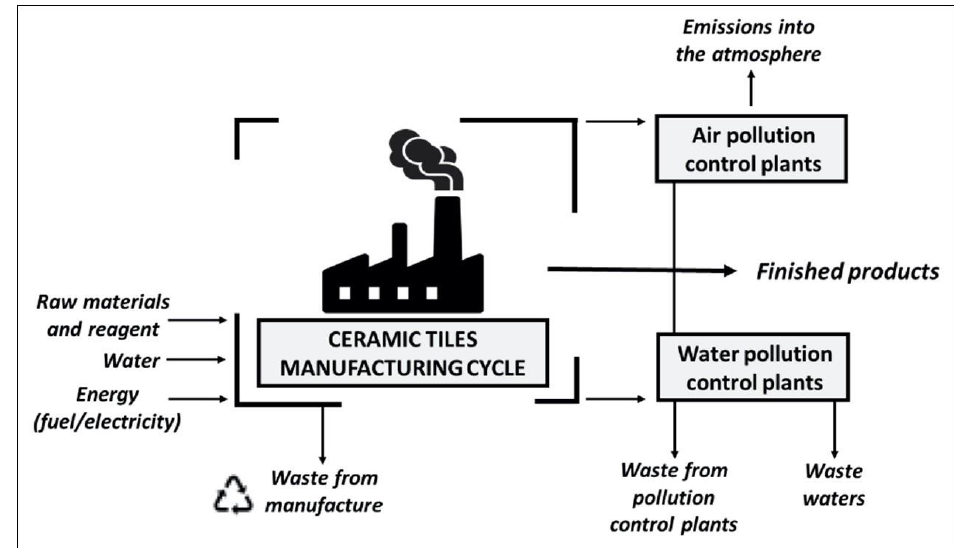
Figure 1. Materials, waste and emissions flows in ceramic tiles production plant.